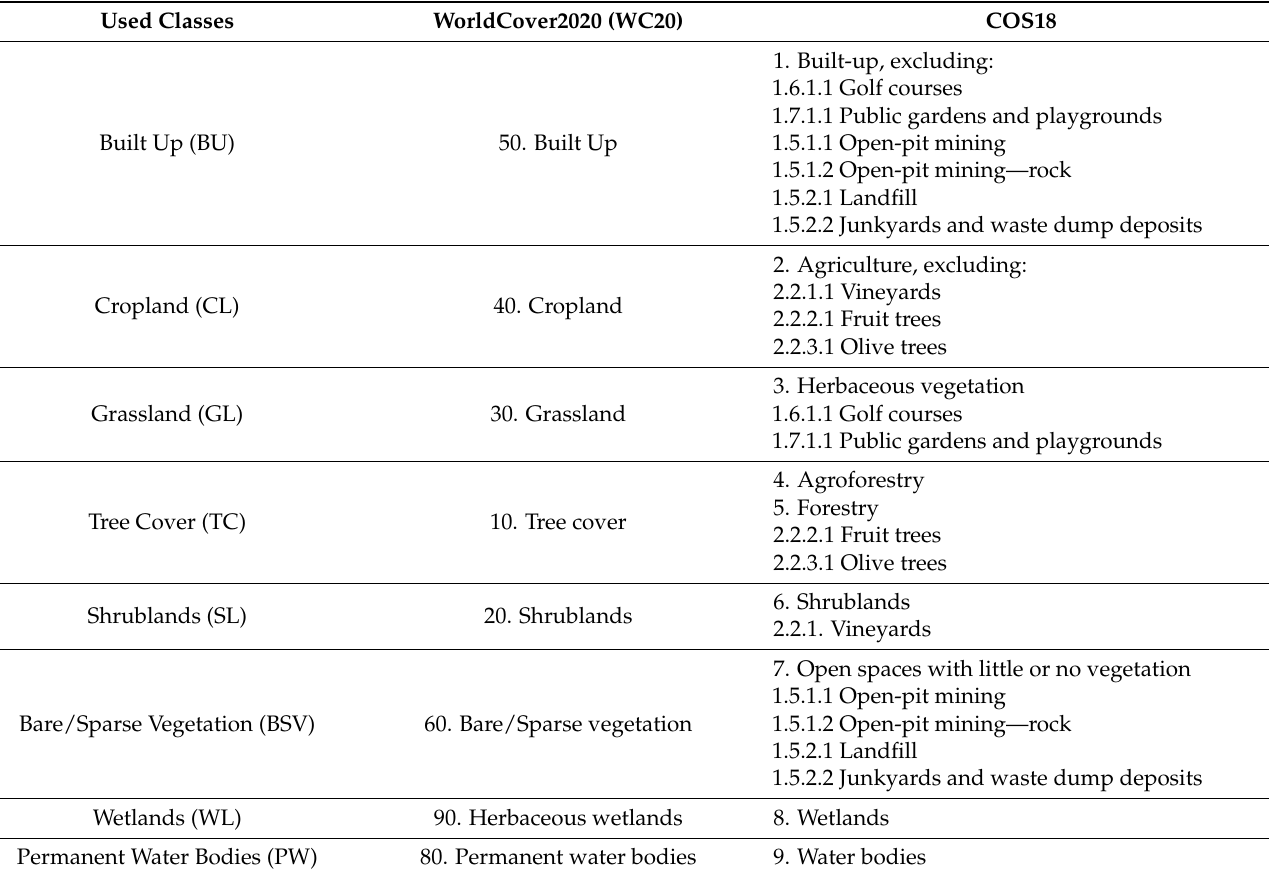
Table 2. Nomenclature harmonization between WC20 and COS18. On the left, the nomenclature used in this study to perform the